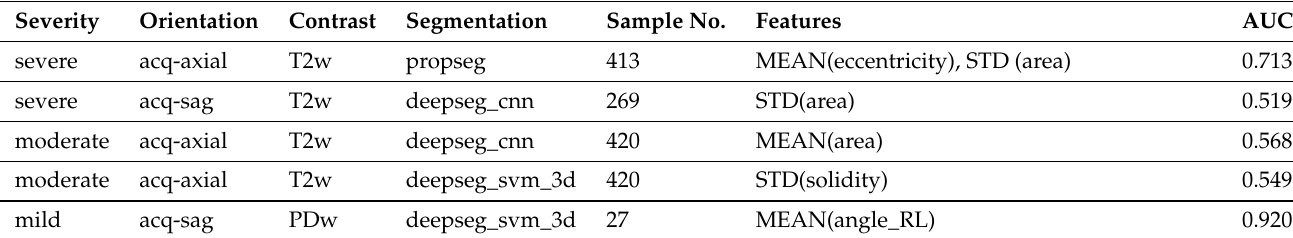
Table 6. The attributes of logistic models fit on metric data, which was standardized to a common scale, but not and harmonized by scanner used via CovBat. Severity indicates the class attempting to be distinguished from all others (binary classification), while orientation, contrast, and segmentation represent the acquisition methodology associated with the model. Features contains the list of features used to train the model, as selected by SciKit-Learn’s SelectFdr